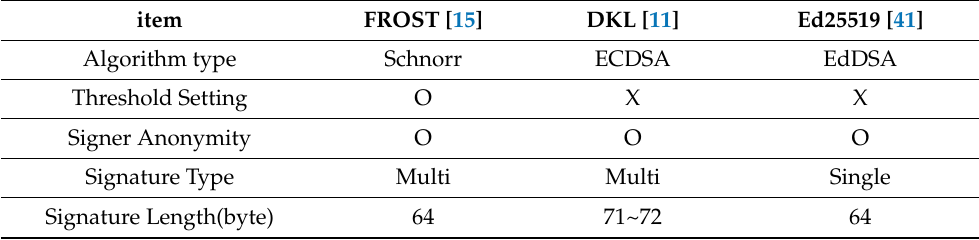
Table 4. Comparisons of threshold signature